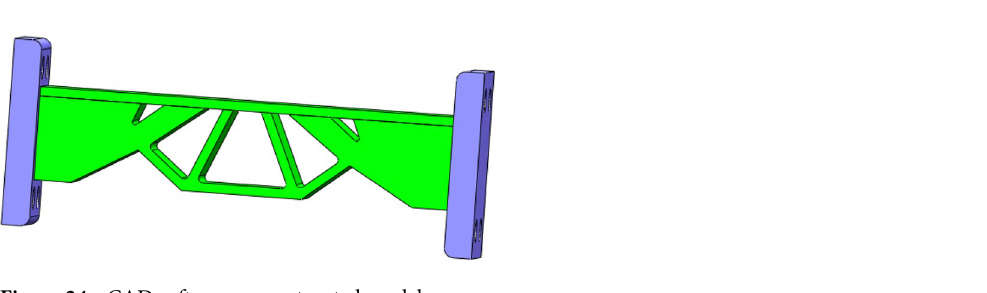
Figure 24. CAD software reconstructed